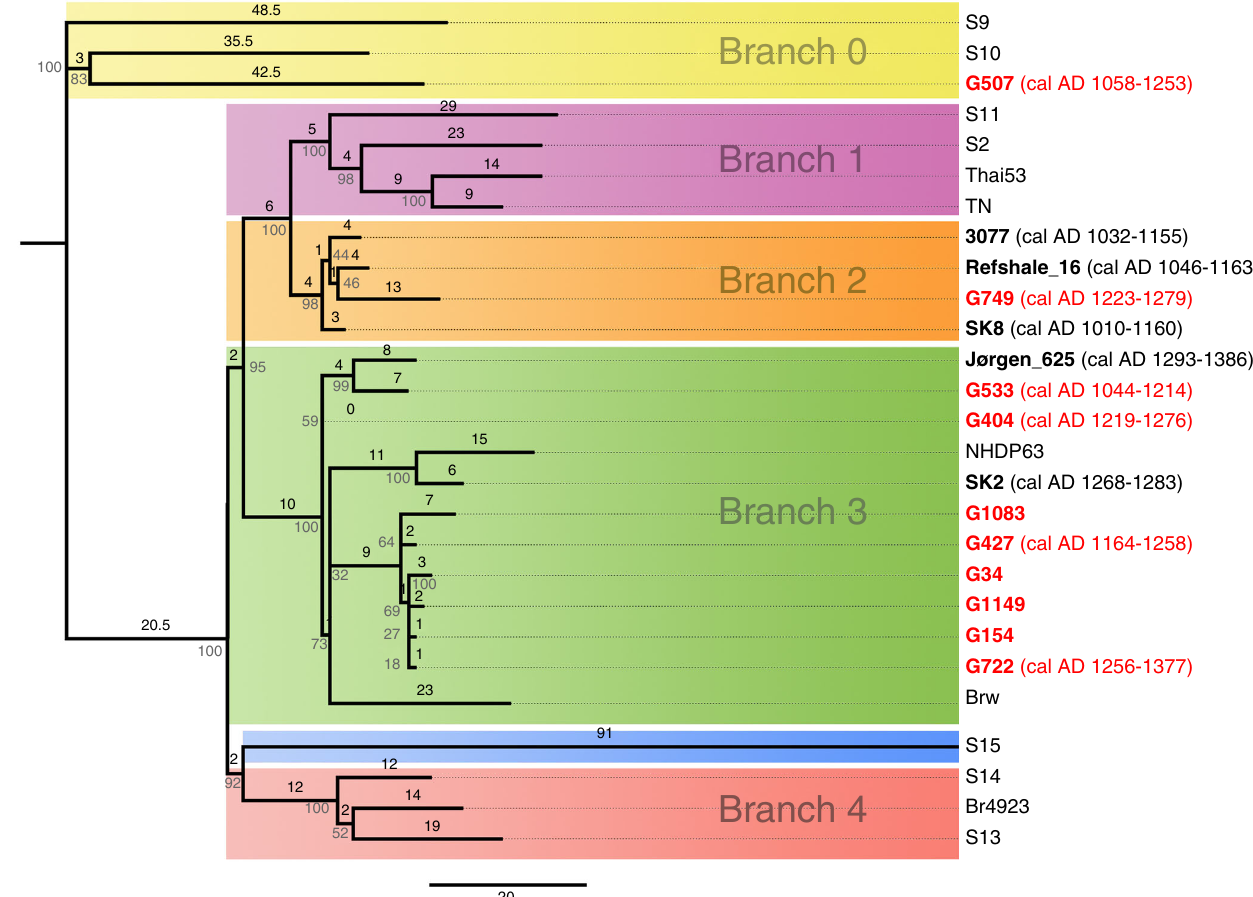
Fig. 3 Phylogeny of medieval and extant M. leprae strains. Phylogeny of medieval and modern M. leprae genomes using a maximum parsimony tree. Labeling colors: red bold (ancient genomes generated in this study), black bold (ancient genomes generated in a previous study (2)) and black (modern genomes generated in previous studies (2, 13)). Calibrated radiocarbon dates (2 sigma range) given in parentheses refer to branch tips. Bootstrap node support (in percent, from 500 replicates) is shown in gray numbers next to the branches, whereas the number of nucleotide sustitutions on each branch is set in black. Color shading highlights different phylogenetic